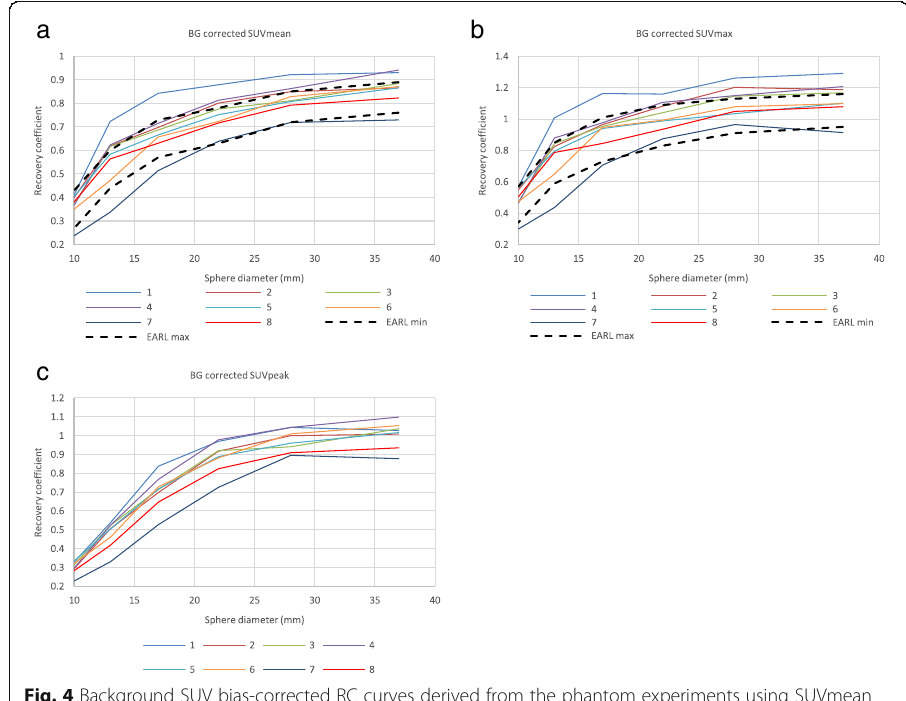
Fig. 4 Background SUV bias-corrected RC curves derived from the phantom experiments using SUVmean ( a ), SUVmax ( b ) and SUVpeak ( c ) quantitative metrics. Current EARL specifications for [ 18 F]FDG-PET/CT accreditation are presented as bold dashed lines. Systems 1 – 2 and 3 – 4 represent GE scanners Discovery 690 and Discovery 710, respectively; systems 5 – 6 are Siemens Biograph 40_mCT and Somatom Definition AS_mCT; system 7 is the Philips Ingenuity TF PET/CT; system 8 is the Siemens Biograph